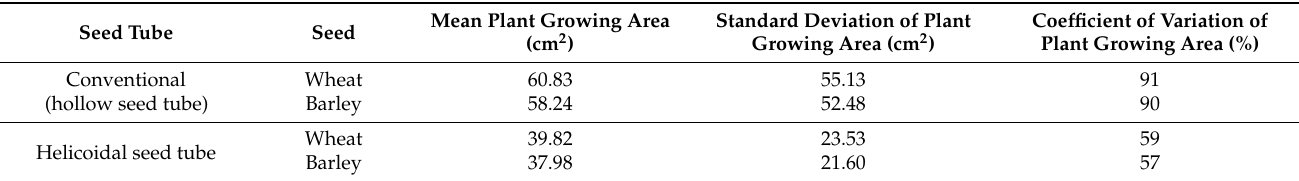
Table 10. The effect of seed tubes on plant growing